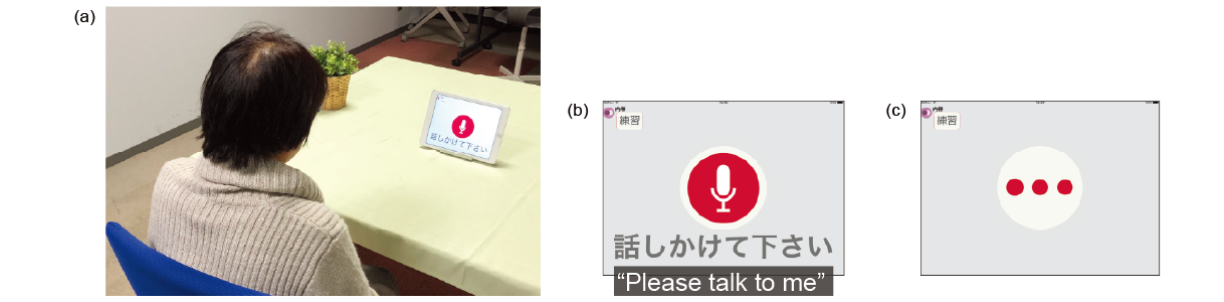
Figure 1. Overview of experimental setup: (a) setup for collecting speech data, (b) screen showing participant's turn, and (c) screen showing the tablet's